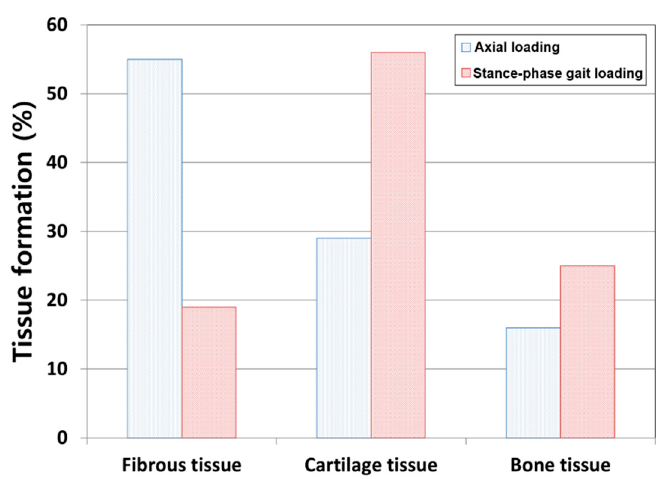
Figure 7. Percentage of each tissue type formation in the axial loading and the stance-phase gait loading model after 40 iterations.